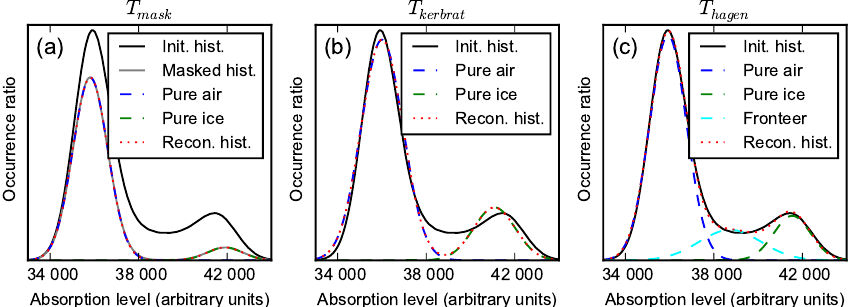
Figure 4. Different intensity models based on the greyscale distribution. (a) Mixture model composed of two Gaussian distributions to reproduce the greyscale distribution on the low-intensity gradient zones. L 1 error between the masked and reconstructed histograms is 0.006. (b) Mixture model composed of two Gaussian distributions to reproduce the whole greyscale distribution. L 1 error between the initial and reconstructed histograms is 0.14. (c) Mixture model composed of three Gaussian distributions to reproduce the whole greyscale distribution. L 1 error between the initial and reconstructed histograms is 0.03. For all figures, the L 1 error is the integral of the absolute difference between the measured and the modelled greyscale distribution. Note that the area under the greyscale distribution of the entire image is 1. 2 2 = n + n σ 2 , with n air and n ice the air σ ice σ w air ice